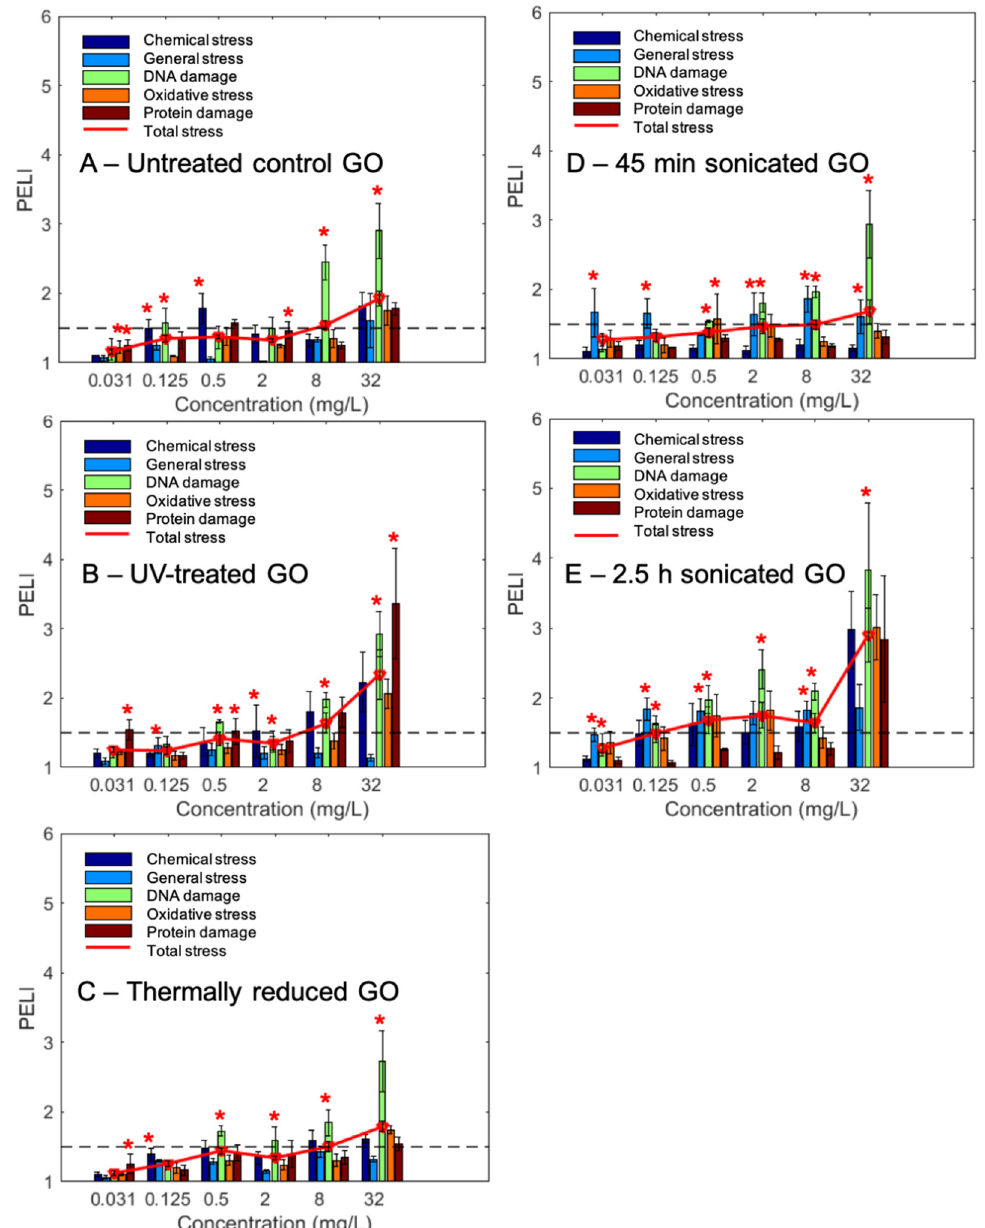
Figure 3. Toxicity profiles of the 5 studied graphene oxides (GOs) in terms of the 5 stress categories and the total protein expression level index (PELI): ( A ) untreated control GO; ( B ) GO treated with 96 h UV; ( C ) GO treated with 96 h thermal reduction; ( D ) GO treated with 45 min bath sonication; and ( E ) GO treated with 2.5 h bath sonication. Toxicity positive was defined as possessing a PELI value larger than a 1.5. x -axis: concentrations of examined GOs (mg/L). y -axis: PELI as molecular toxicity endpoint. Mean ± SD, replication number n = 3, * p <